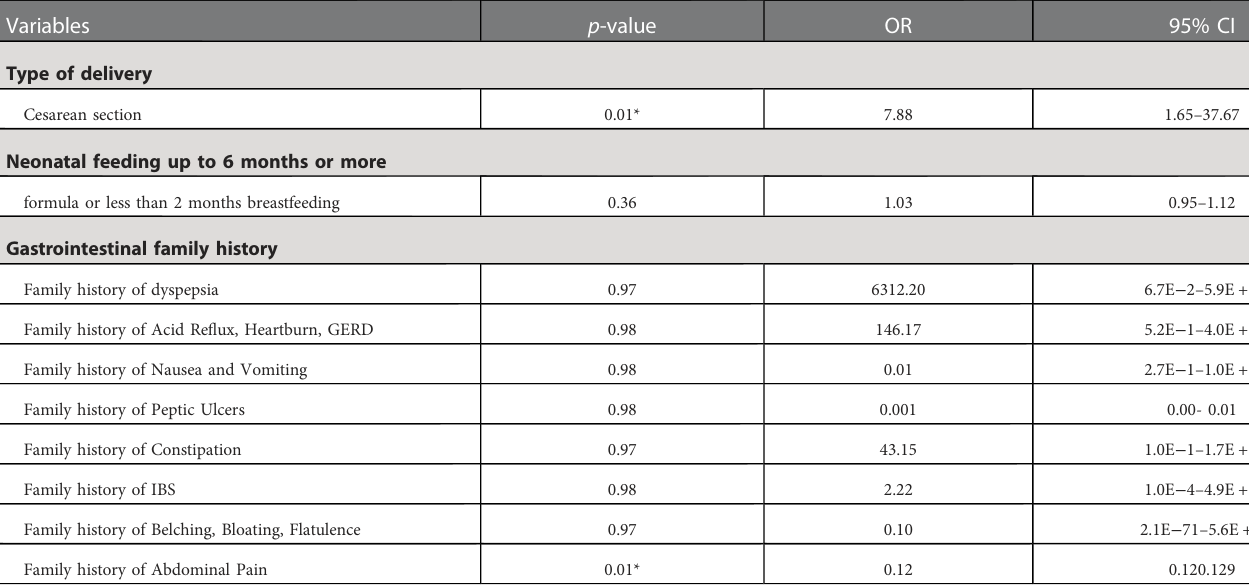
TABLE 7 Multivariate regression analysis: tests of FGIDs predictors among family histories of diseases and neonatal delivery and feeding.